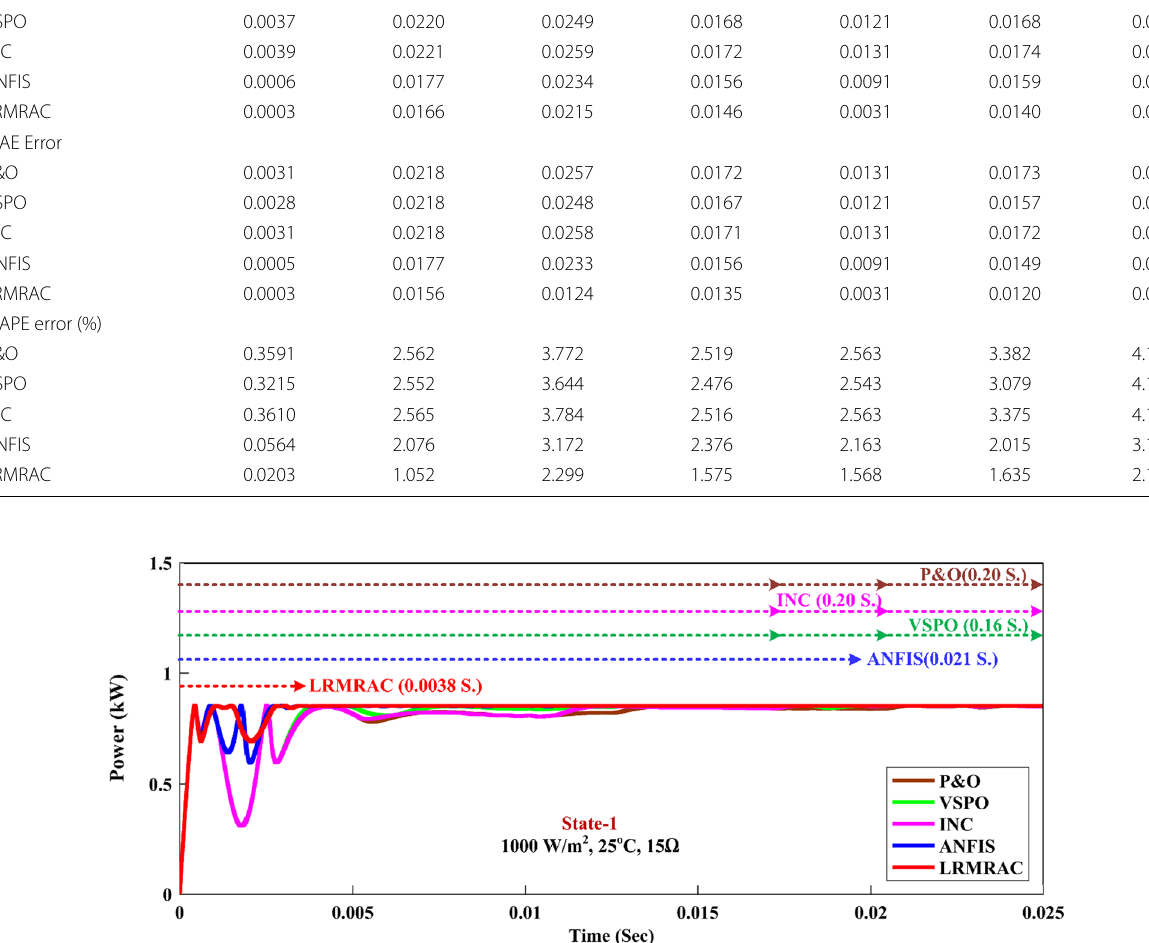
Fig. 14 Speed of the different MPPT algorithms while temperature, irradiance, and load all change at